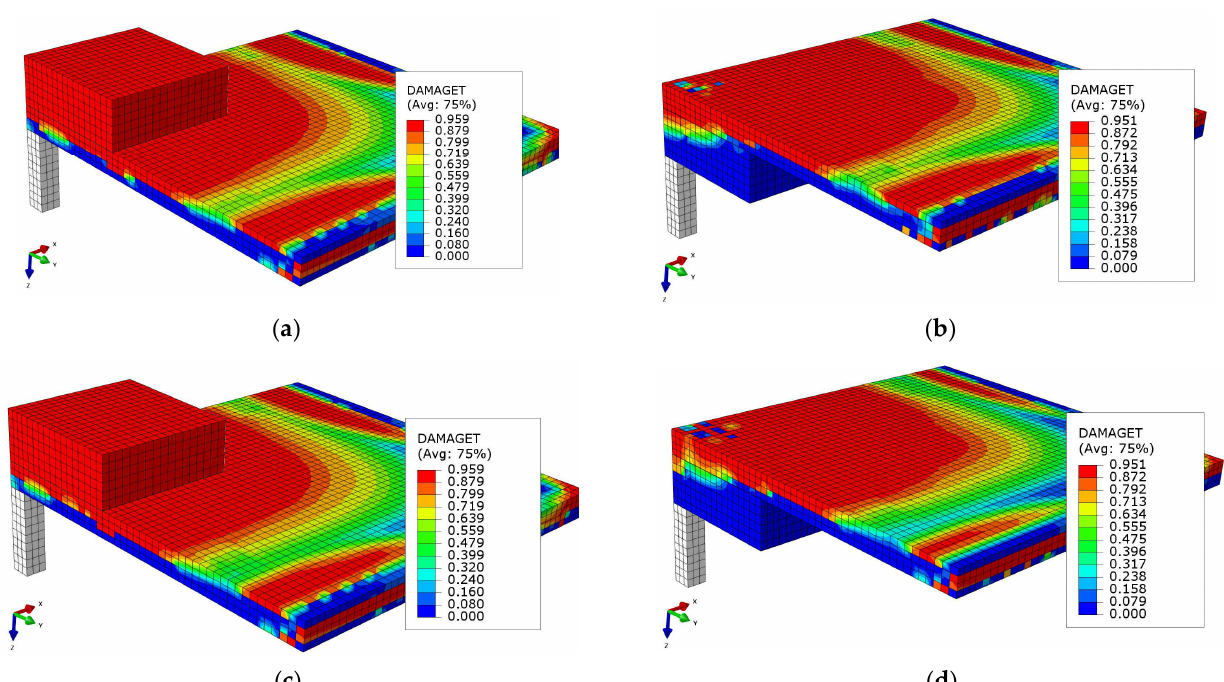
Figure 16. Tensile damage diagrams of tensile sides of specimens ZM01–ZM04 at failure load: ( a ) ZM01; ( b ) ZM02; ( c ) ZM03; and ( d ) ZM04.